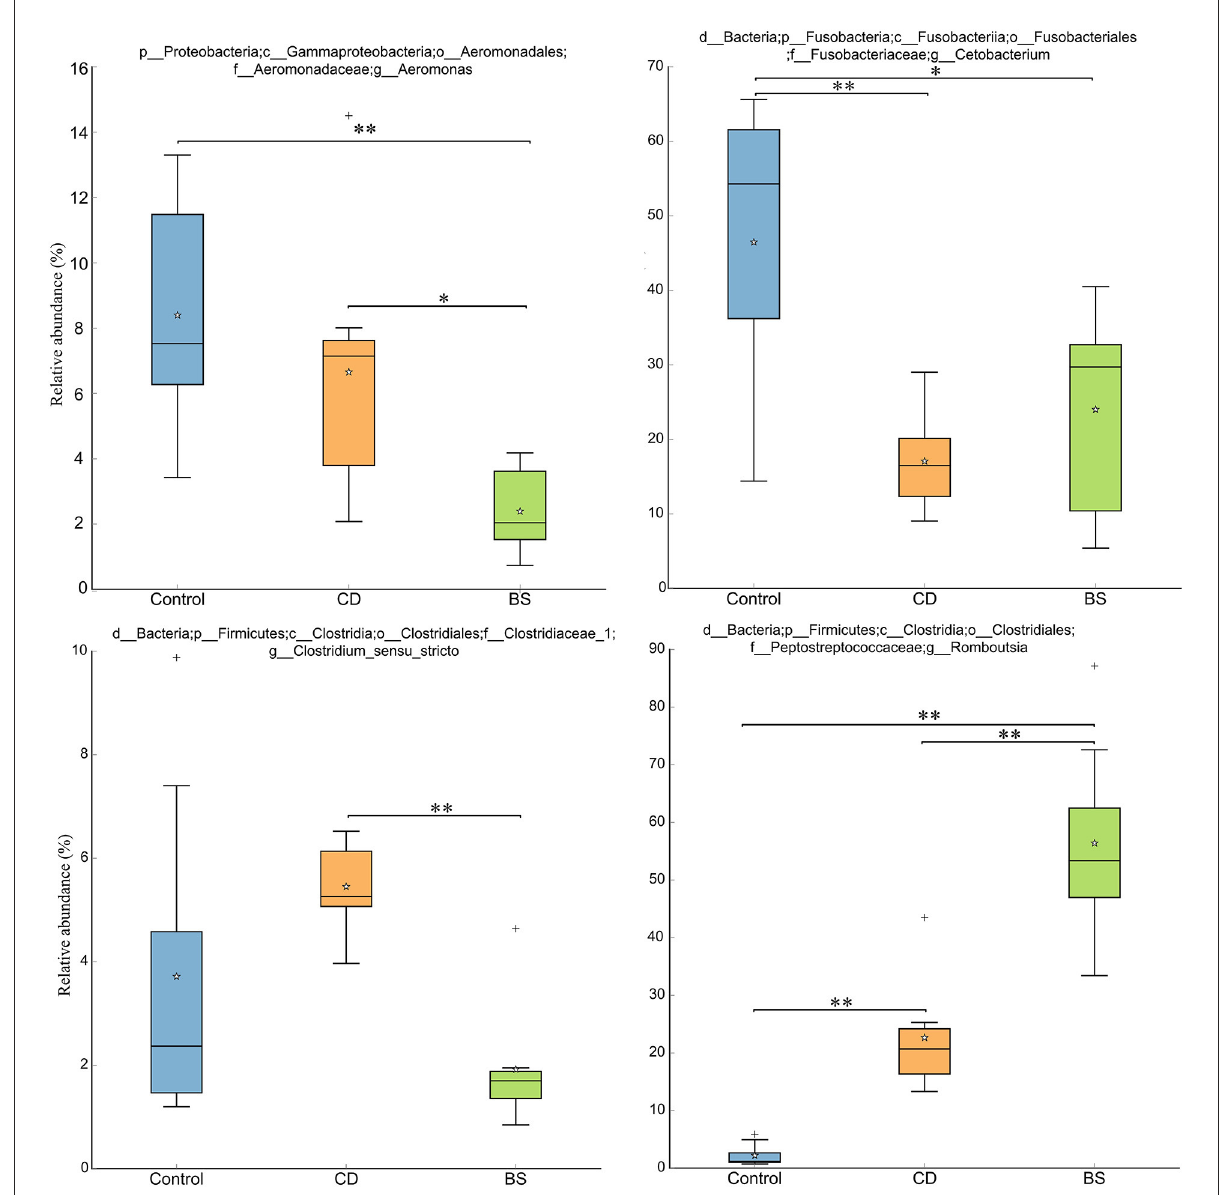
FIGURE3 Box plots showing significant variations of relative abundances of intestinal microbiota. ** P < 0.01, * P <